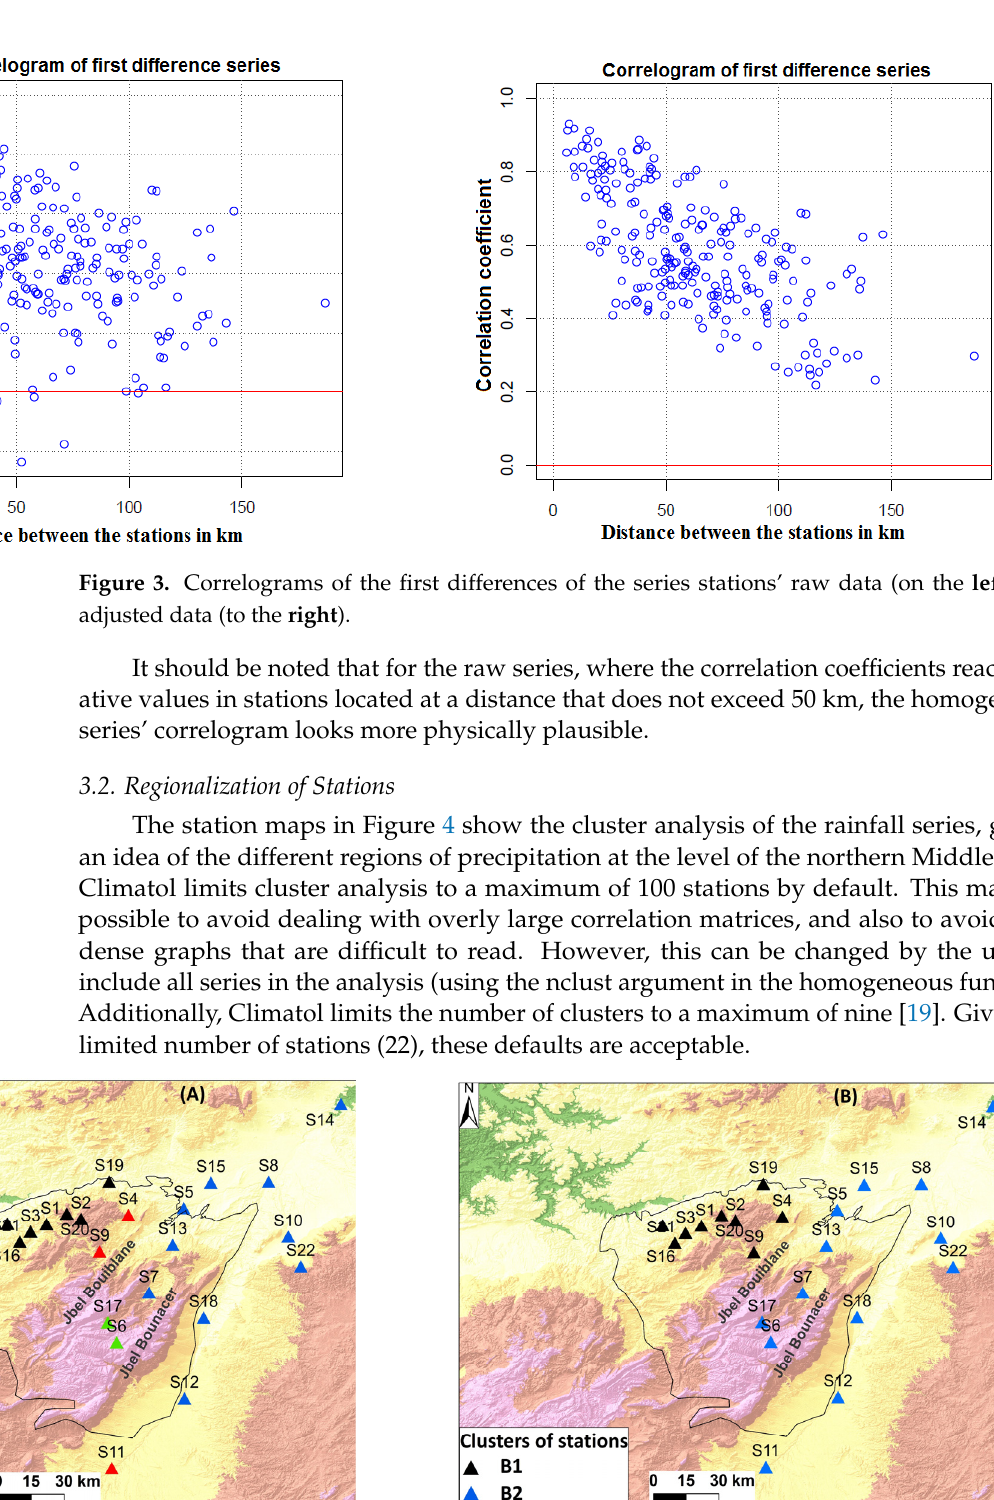
Figure 5. Monthly rainfall regime of the two clusters ( B1 , B2 ) after homogenization. 0